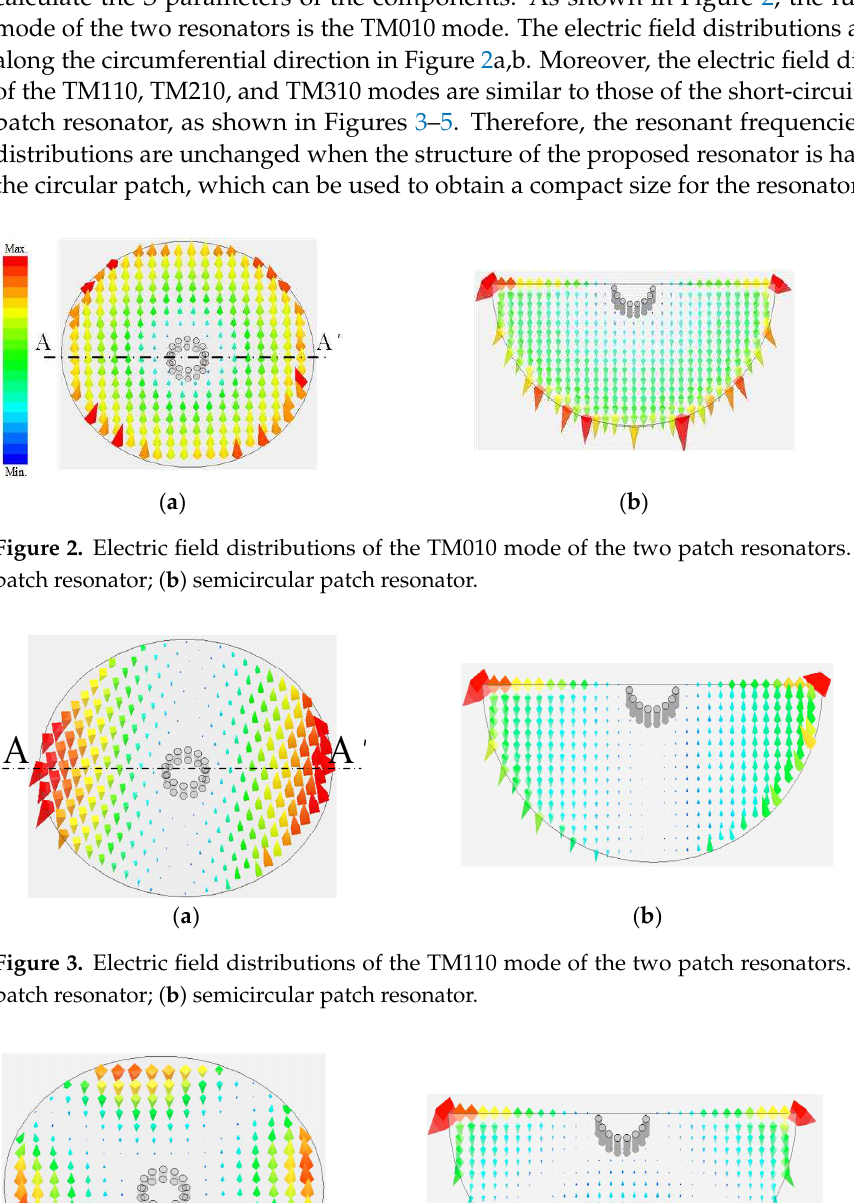
Figure 1. Geometric structures of the short-circuited circular and semicircular patch resonators. ( a ) Circular patch resonator; ( b ) semicircular patch resonator.